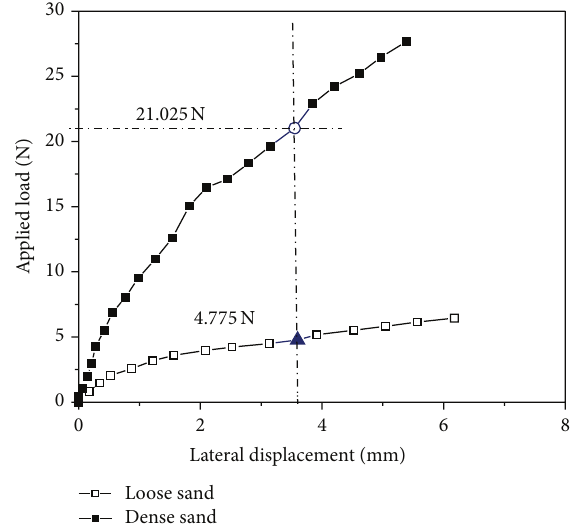
Figure 2: Curvesofapplied load versus lateral displacement in loose and dense